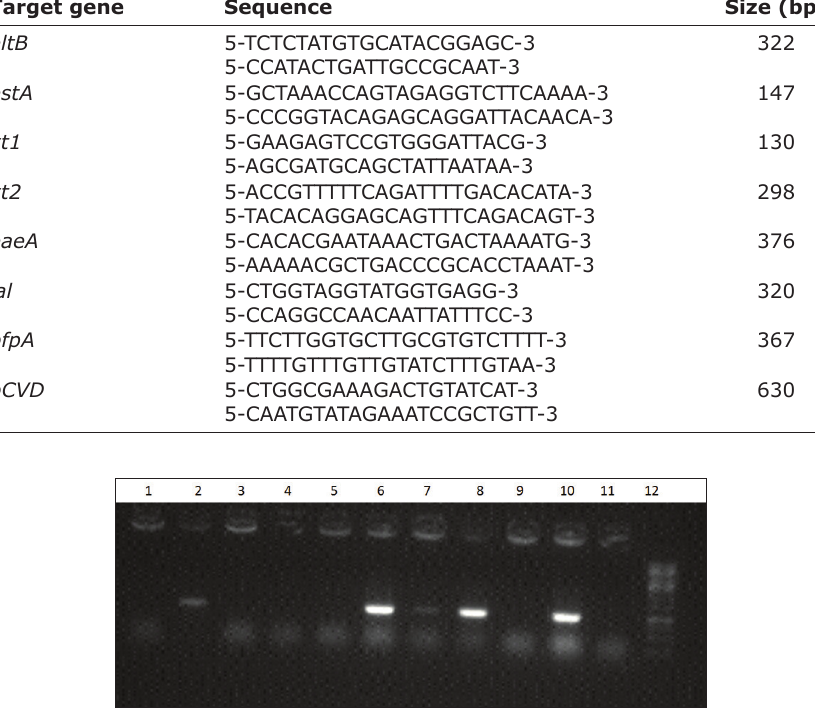
Figure-S1: Representative of molecular identification of Escherichia coli strains using uspA gene primers. Lines 2, 6, 7, 8, and 10 show the presence of uspA genes in the isolates. Line 12 is DNA ladder.